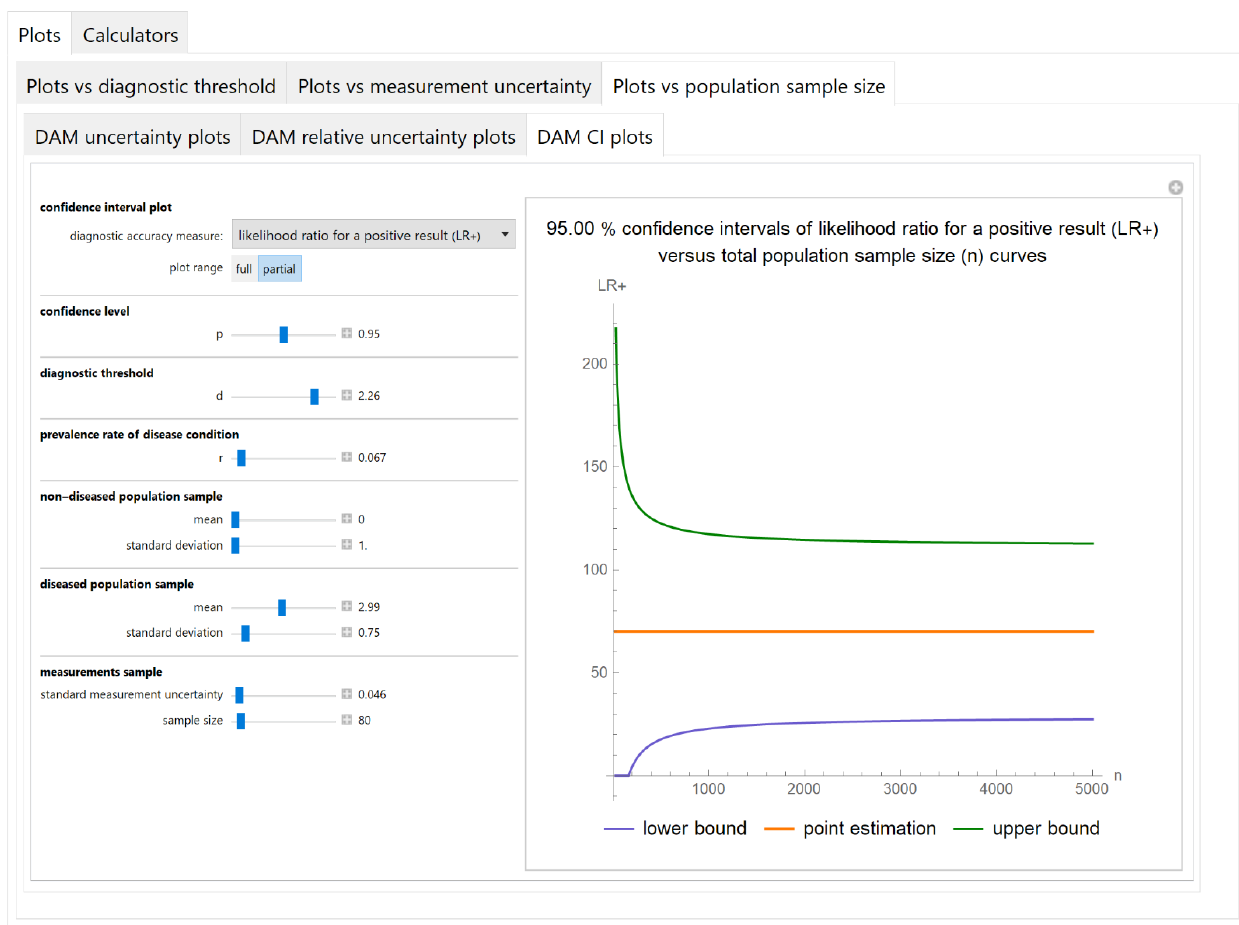
Figure 11. Plots vs. population sample size module, DAM CI plots submodule screenshot. Confidence intervals of likelihood ratio for a positive test result ( LR+ ) versus total population sample size ( n ) curves plot, with the settings shown at the left. The respective parameter settings are also shown in Table 3.